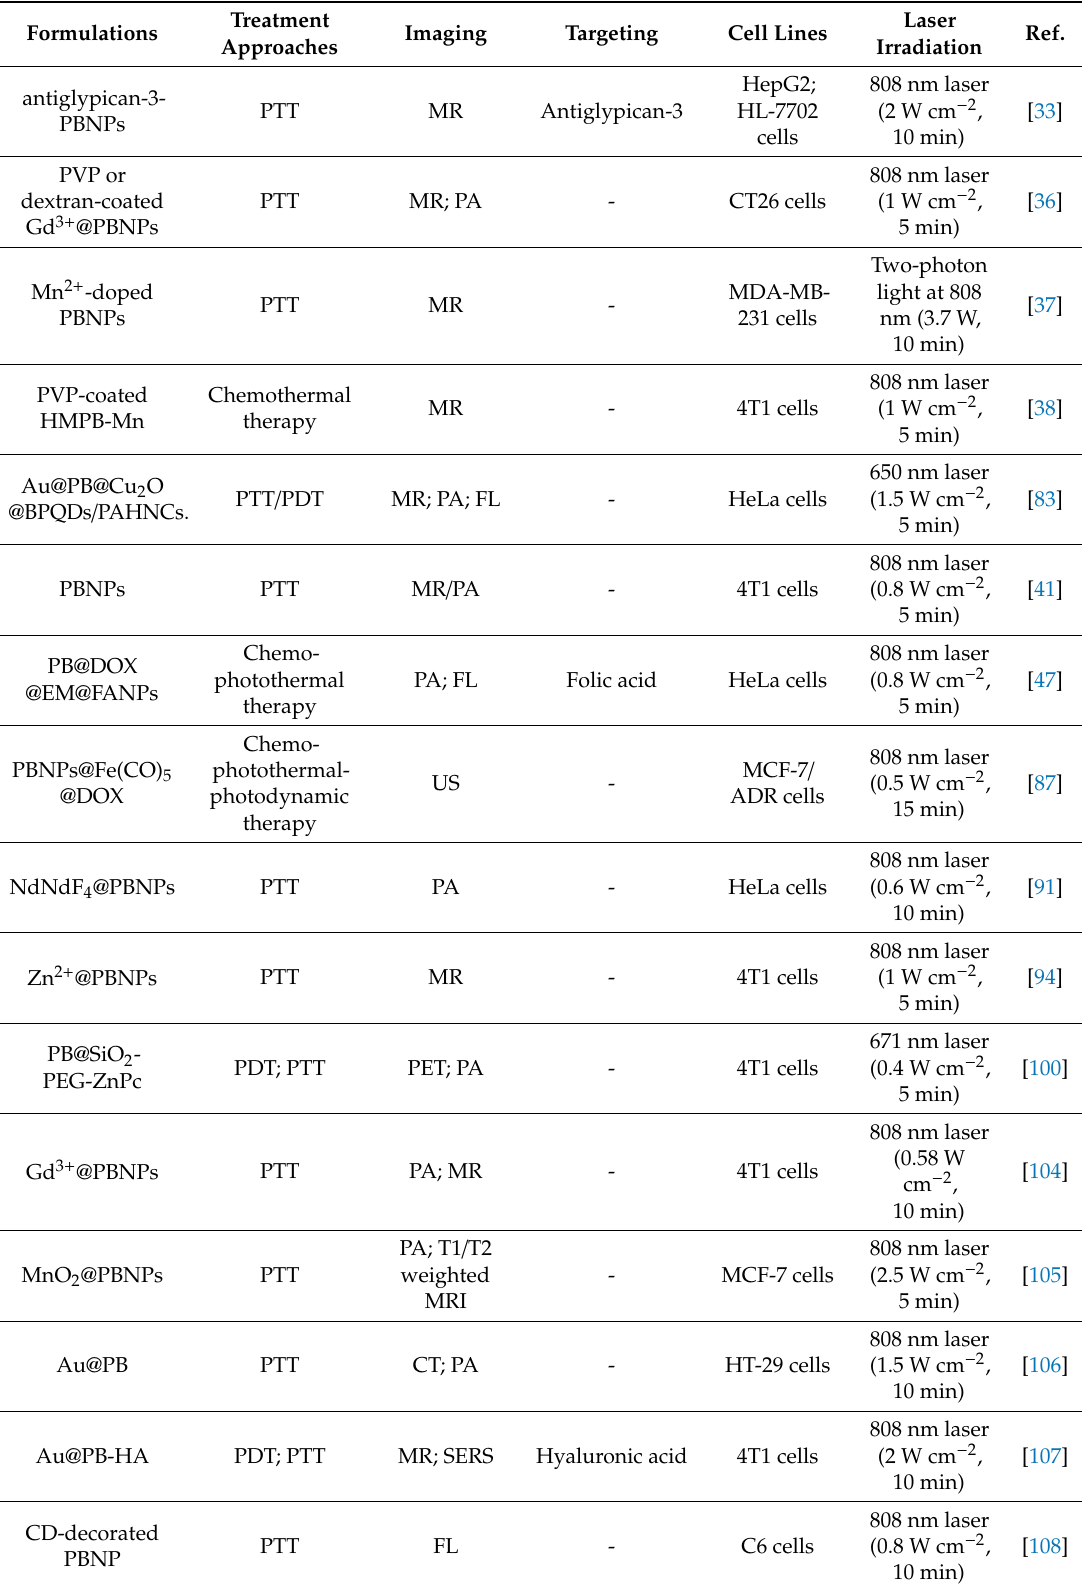
Table 3. Summary of therapeutic PBNPs-based nanomaterials for imaging-guided tumor treatment.